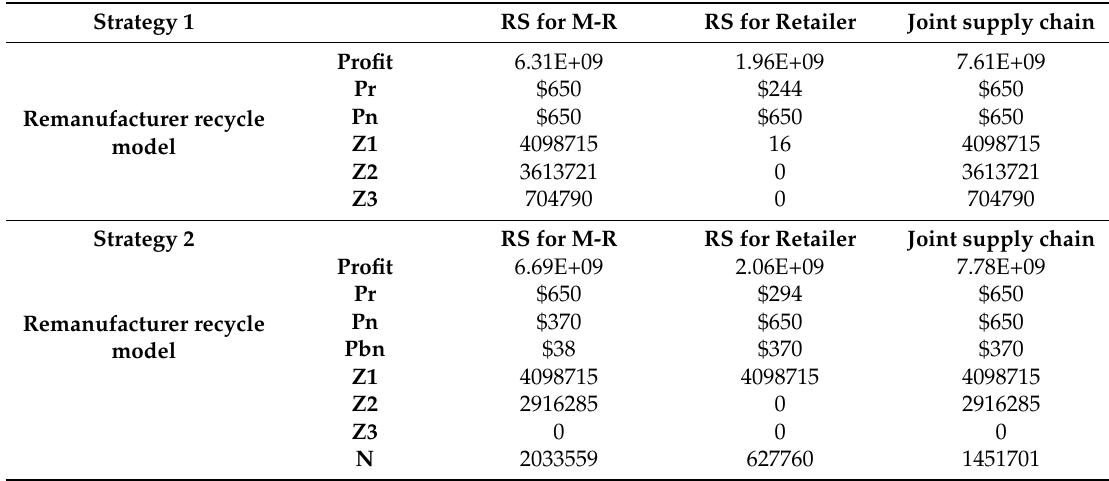
Table 6. Remanufacturer-recycle model for two acquisition